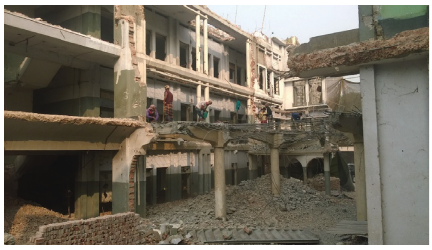
Figure 1: Demolition of existing building. Figure 4: Stack of Induction Furnace slag.